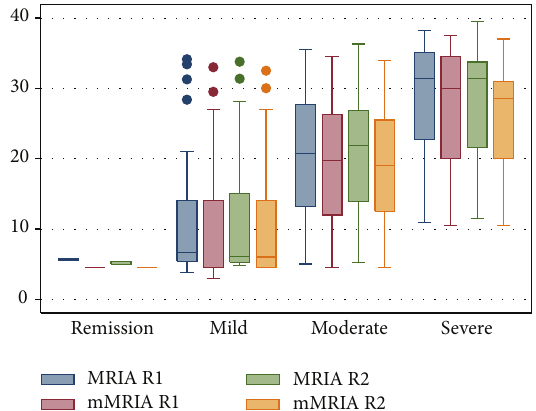
Figure 8: Box-plot diagram of MRIA and mMRIA values related to disease activity groups for both R1 and